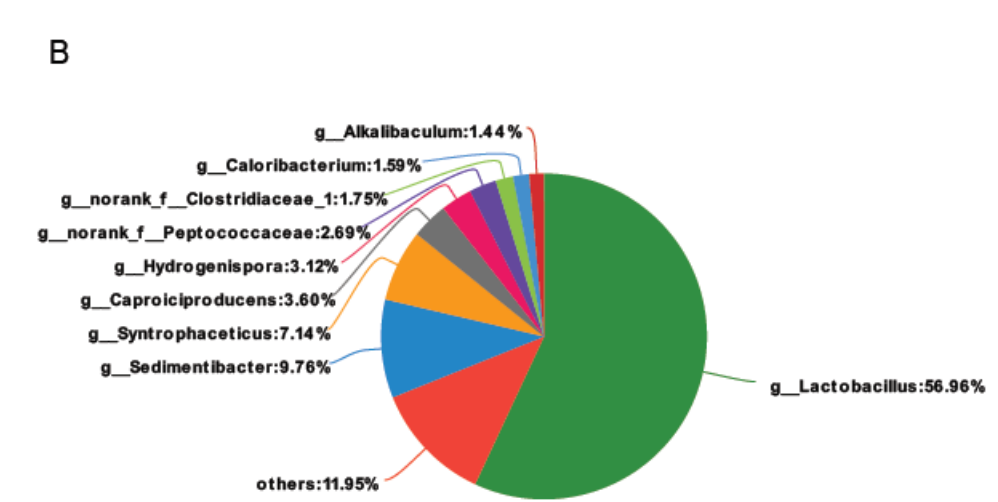
Figure 2. Common microbes between yellow water and pit mud. ( A ) Venn diagram of yellow water and pit mud, ( B ) Percentage of common microbes between yellow water and pit mud (at the genus Figure 2 . Common microbes between yellow water and pit mud. A : Venn diagram of yellow water and pit mud, B : Percentage of common microbes between yellow water and pit mud (at the genus level).